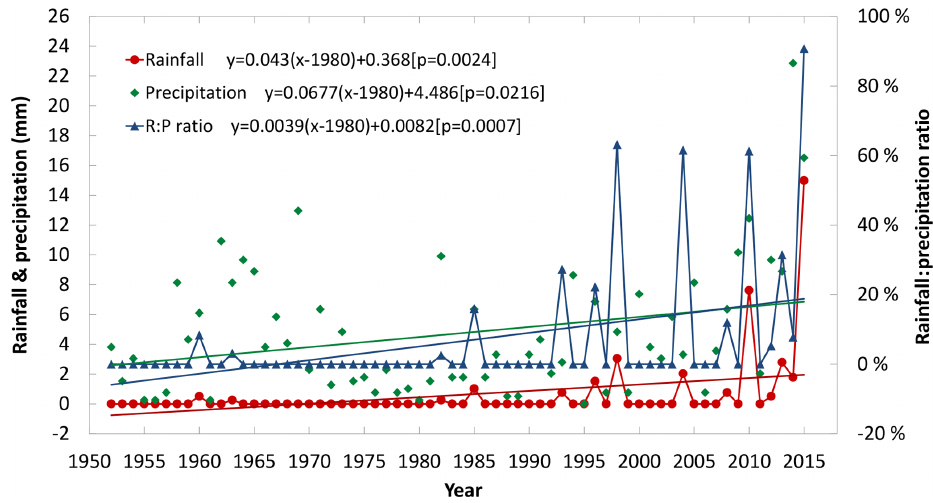
Figure 8. The variation trend of rainfall, total precipitation and R : P ratio at Utqia ˙ gvik for May, 1952–2015. p denotes the significance value of the linear